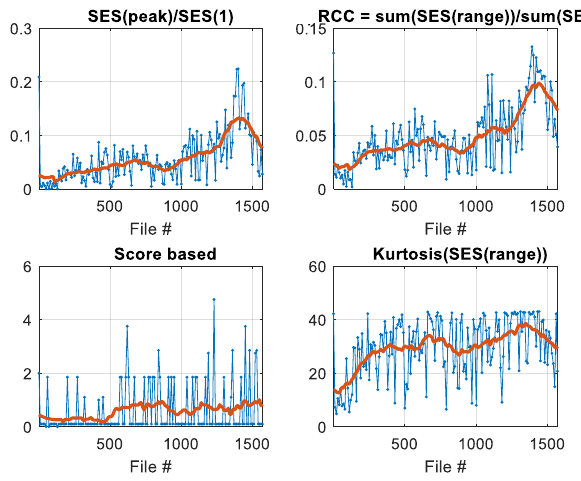
Figure 9. Values of the normalized SES for some data records—left TB. It is interesting to observe in Figure 8 that SES based indices present a non-monotonic trend close to the end of the test campaign. The change of the trend of these kind of indices has been already observed and described in detail in other papers by the same authors [27] and by other authors [35,36] and is typically related to the wear evolution in rolling element bearings. In this paper, for the sake of brevity, a full discussion is not presented, but the trend change occurs in the phases of “defect initiation” and “defect propagation” during the lifetime of the bearing.